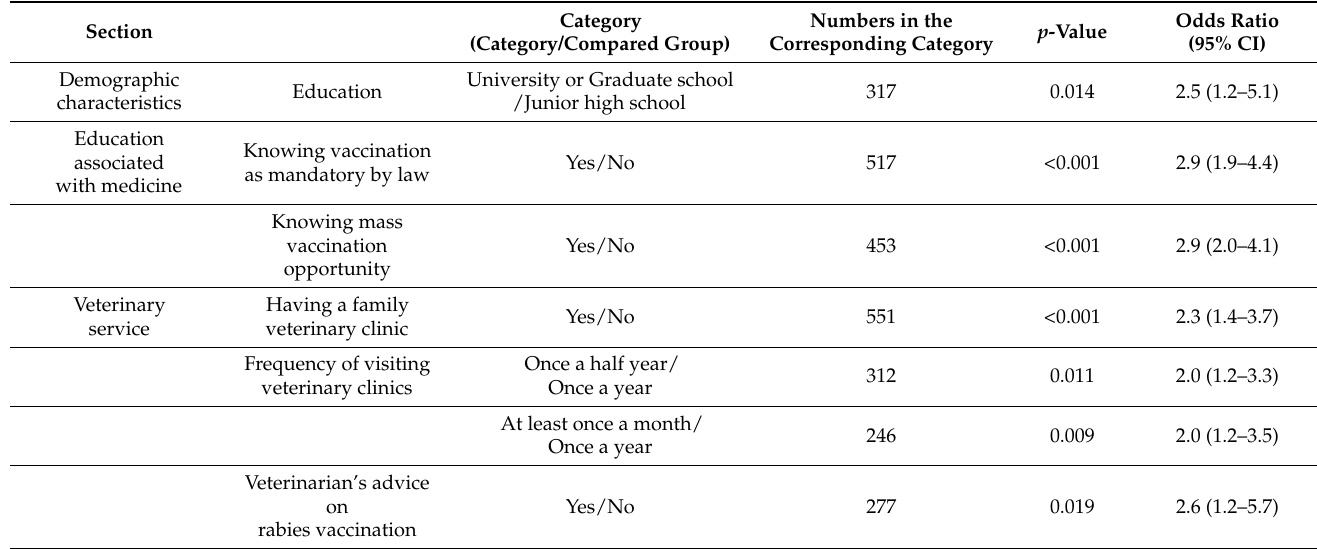
Table 2. Univariate associations between dog rabies vaccination and owner